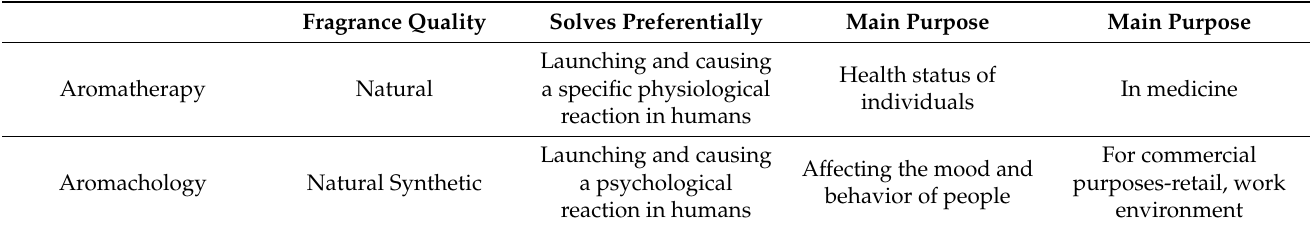
Table 1. Differences between Aromatherapy and Aromachology.